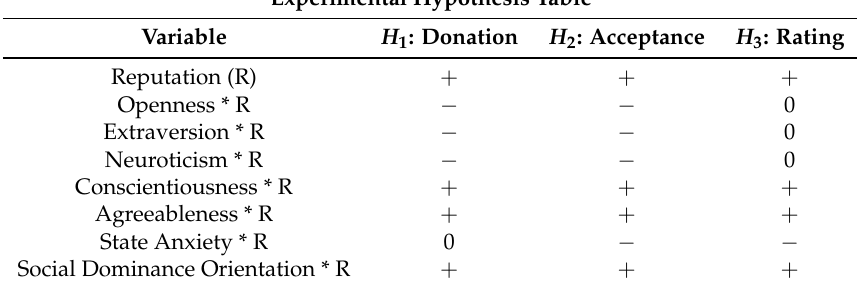
Table 1. Summary of Experimental Hypotheses: in the table are reported the literature predictions on the effects of reputation and psychological traits in interaction with the reputation (R), on Donation, Acceptance, and Rating. Experimental Hypothesis Table Variable H 1 : Donation H 2 : Acceptance H 3 : Rating Reputation (R) + + + Openness * R − − 0 Extraversion * R − − 0 Neuroticism * R − − 0 Conscientiousness * R + + + Agreeableness * R + + + State Anxiety * R 0 − − Social Dominance Orientation * R + +